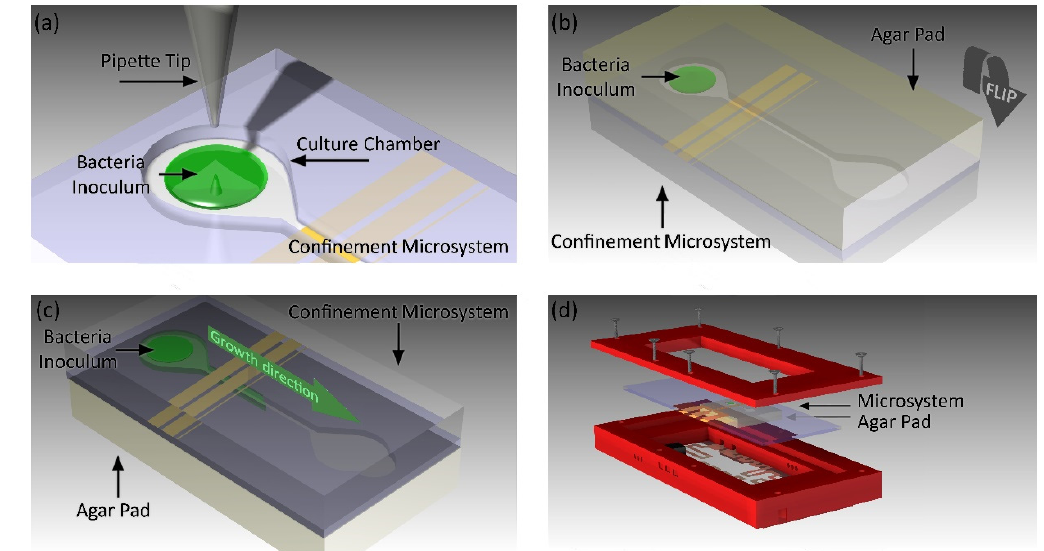
Figure 3. Diagram of the microculture process. ( a ) Inoculum (1 µ L) was placed inside one of the culture chambers. ( b ) Carefully, an agar pad is placed on top of the microsystem. ( c ) The microsystem was turned over, allowing bacterial growth towards the microelectrodes. ( d ) The microsystem was placed inside the test cell.